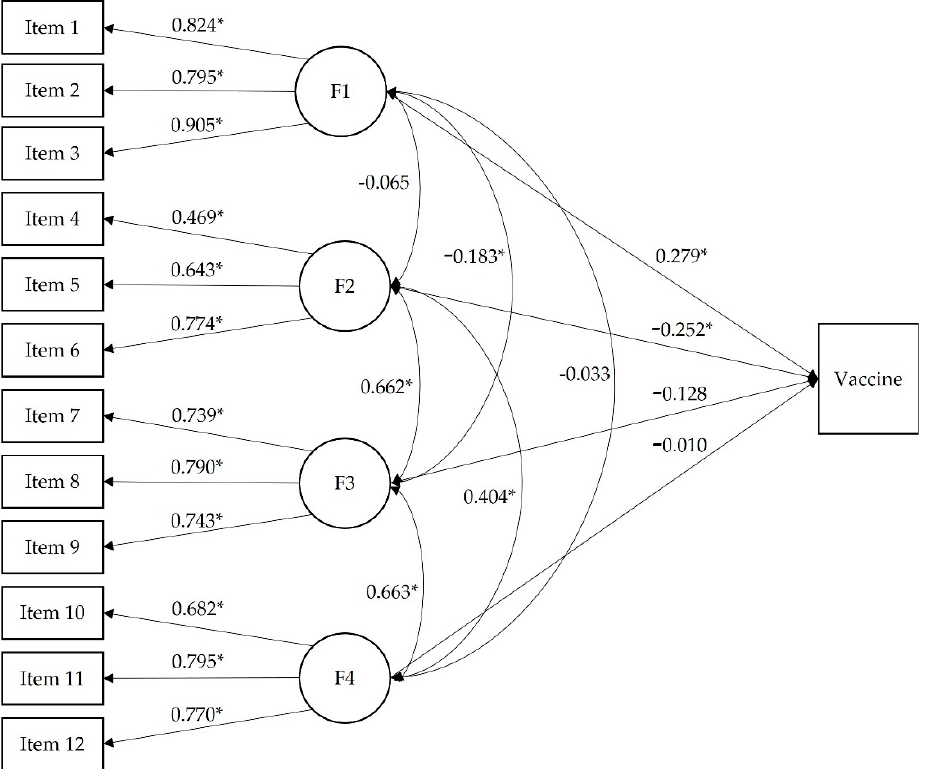
Figure 2. Standardized coefficients for validity model of the Vaccination Attitudes Examination Scale. Reference group for Vaccine: Yes. Note: F1 = trust of vaccine benefit; F2 = worries over unforeseen future effects; F3 = concerns about commercial profiteering; and F4 = preference for natural immunity. * p < 0.001